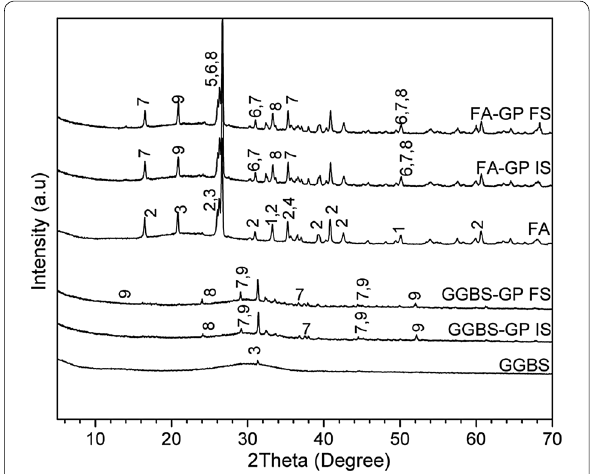
Fig. 2 XRD pattern of raw materials and geopolymers at setting periods. 1: Hematite, 2: Mullite, 3: Quartz, 4: Corundum, 5: Ettringite, 6: N-A-S, 7: N-C-A-S, 8: C-A-S-H, 9: